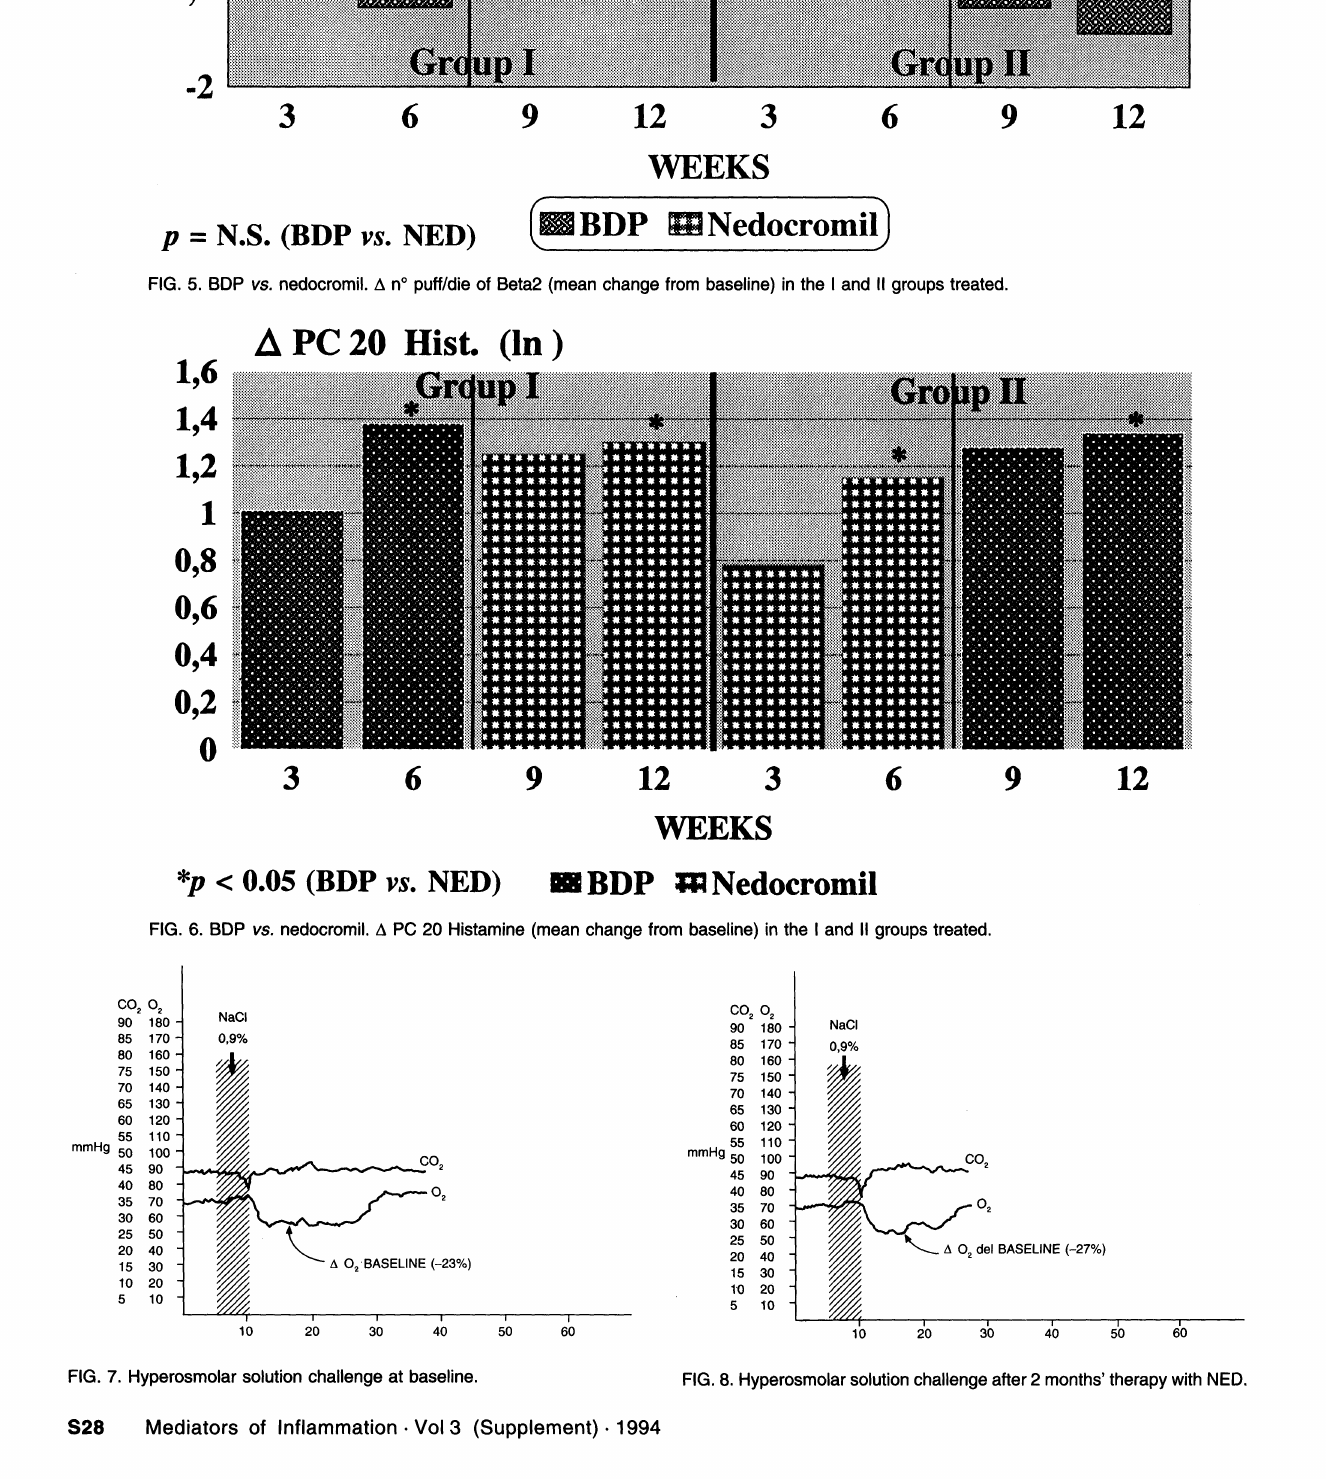
FIG. 7. Hyperosmolar solution challenge at baseline. S28 Mediators of Inflammation. Vo13 (Supplement). 1994